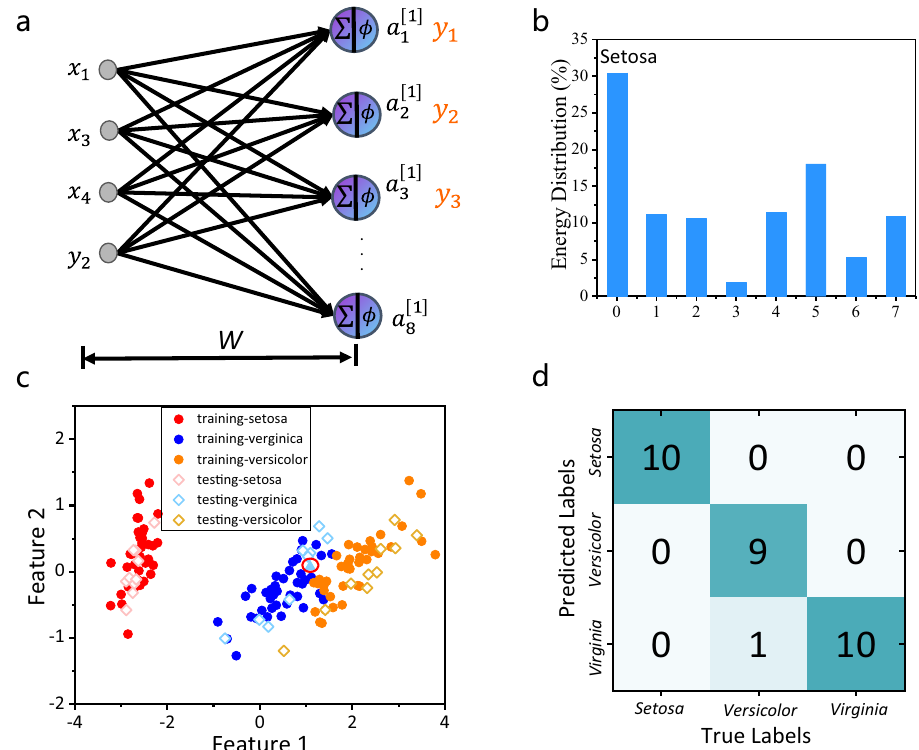
Fig. 4 Iris fl ower classi fi cation using the diffractive neural network. a Network consists of one layer. The outputs of the layer are the recognition results after the intensity detection. x 1 is sepal length, x 2 is sepal width, x 3 is petal length, and x 4 is petal width. y 1 is Setosa , y 2 is Versicolor , and y 3 is Verginica . b Experimental output intensity distribution of the IDNN for a class of fl owers as “ Setosa ” is demonstrated. c Training and testing results of classi fi cation. One classi fi cation error appears on the testing part. d Confusion matrix in our experiment using 30 different fl